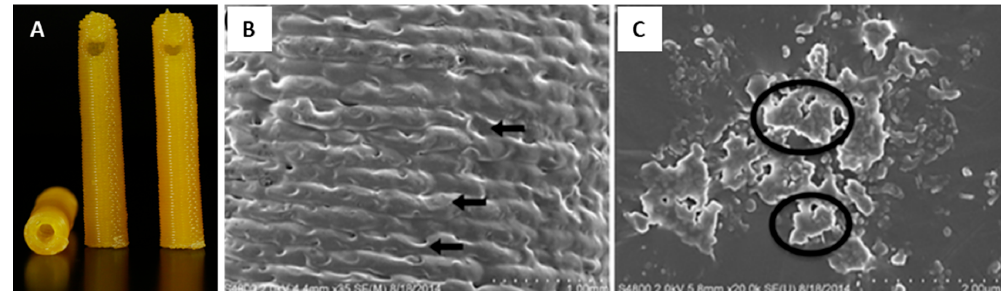
Figure 4. Photograph of the methotrexate-laden three-dimensional (3D)-printed catheter ( A ). Scanning electron microscope images of gentamicin-laden 3D-printed catheters ( B , C ). Multiple